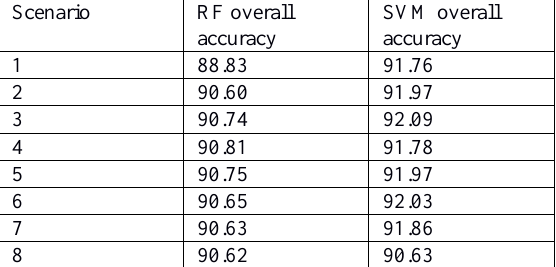
Table 4. Overall accuracy of RF and SVM image classification methods in seven defined